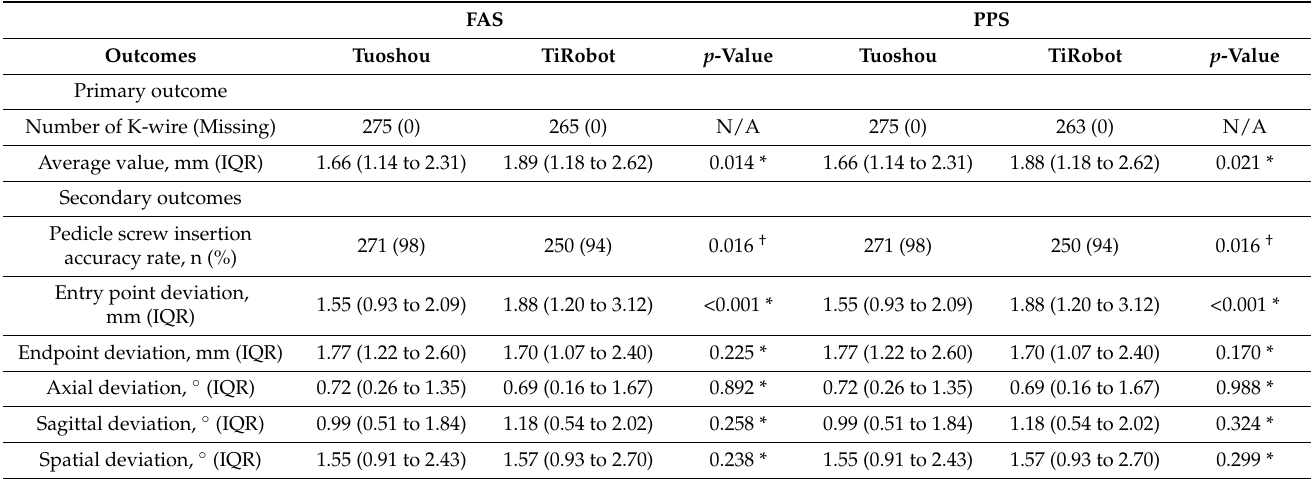
Table 4. Primary and secondary outcomes of FAS and